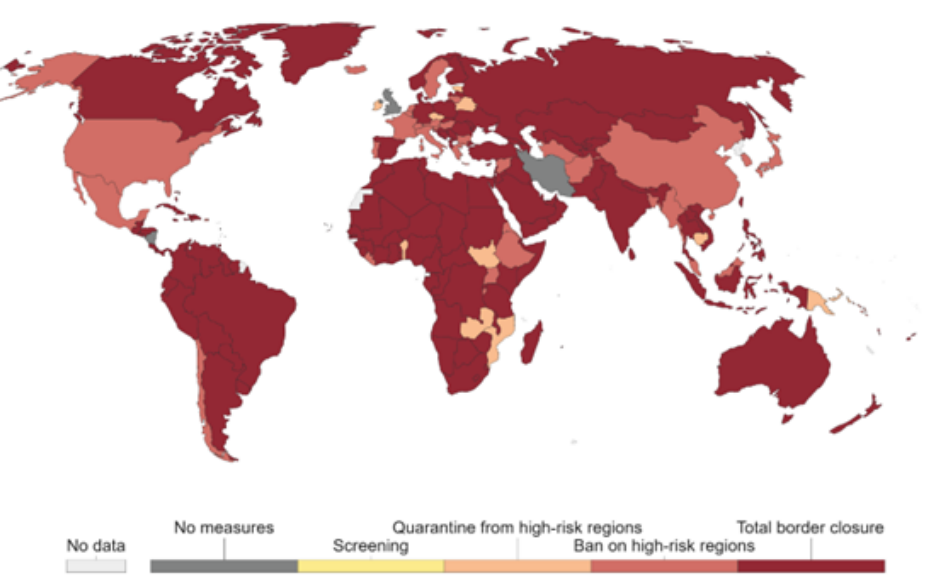
Figure 2. International travel controls during COVID-19, 13 May 2020